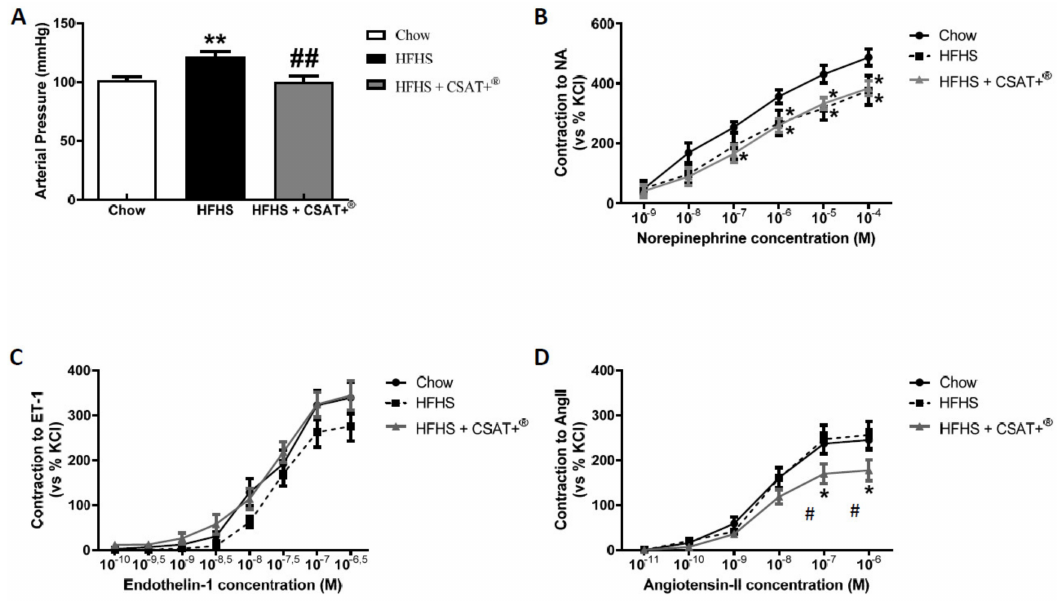
Figure 4. Mean arterial pressure ( A ) and vascular response of abdominal aortic rings to cumulative dose-response of norepinephrine (10 − 9 to 10 − 4 M) ( B ), endothelin-1 (10 − 10 to 10 − 6.5 M) ( C ) angiotensin-II (10 − 11 to 10 − 6 M) ( D ) of mice fed a standard diet (Chow), a high fat diet / sucrose diet (HFHS) or high fat diet / sucrose diet supplemented with the carob pod extract (HFHS + CSAT + ® ). * p < 0.05; ** p < 0.01 vs. chow. # p < 0.05; ## p < 0.01 di ff erence vs. HFHS. Values are represented as mean ± S.E.M; n =